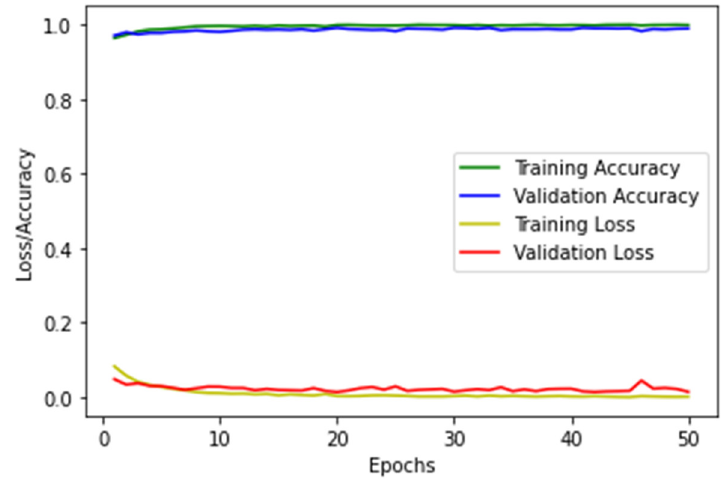
Figure 7. Training and validation progress of EfficientNetB0.